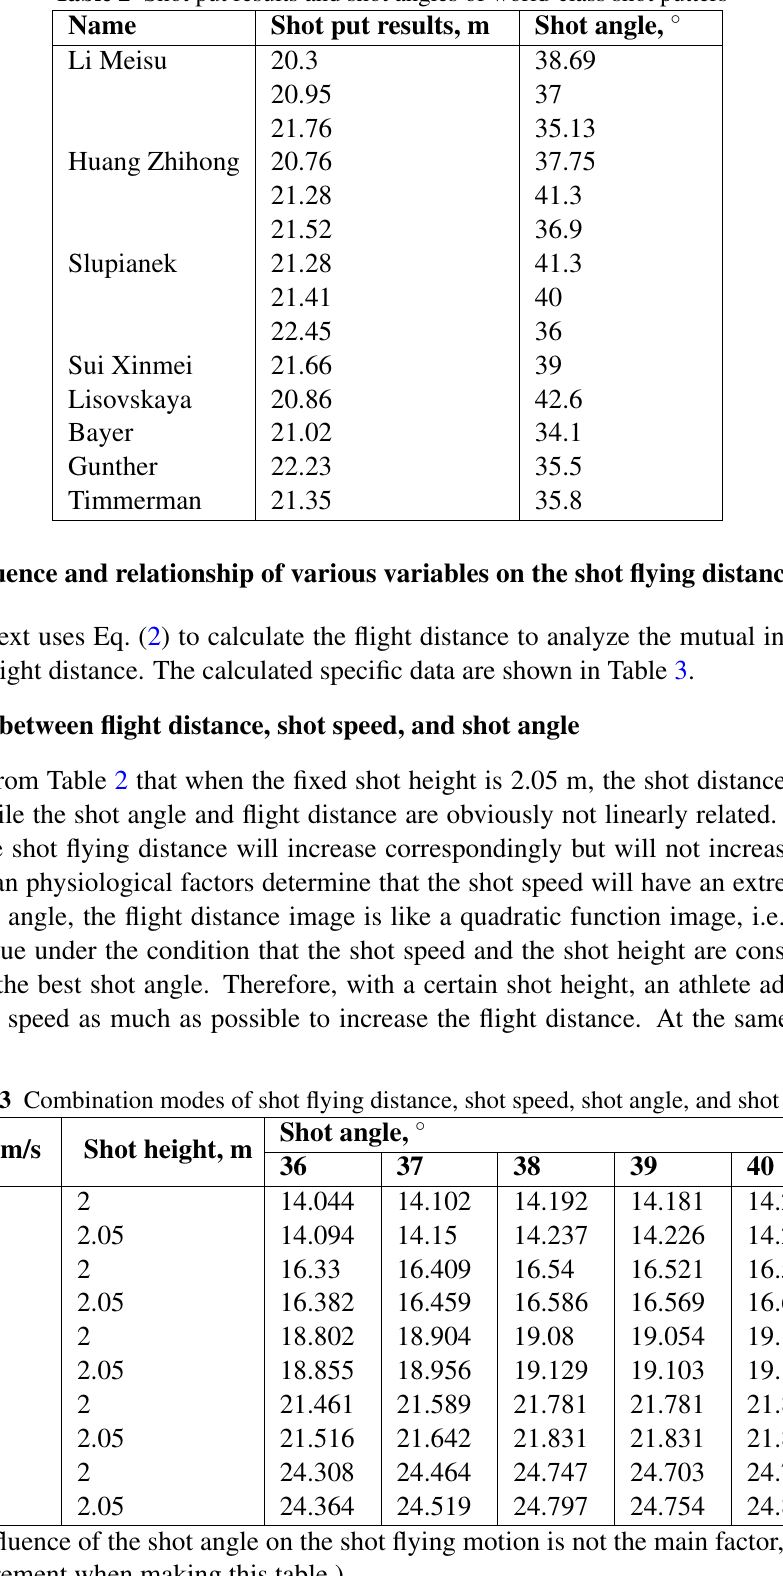
Table 2 Shot put results and shot angles of world-class shot